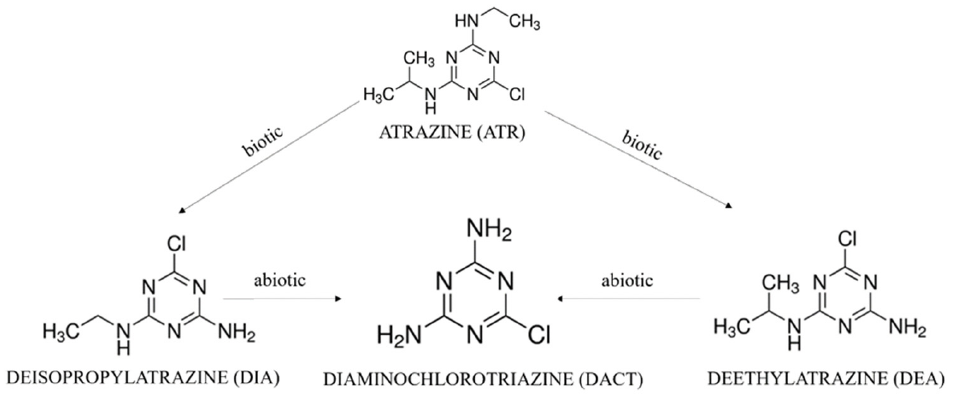
Figure 1. Structure of atrazine and its hydrophilic metabolites, DIA, HA, and DEA. Although practices that minimize atrazine runoff and make it hold onto the field have been promoted [8], atrazine has been detected in the natural environment. Water soluble metabolites, deisopropylatrazine (DIA; 6-chloro- N -ethyl-[1,3,5]triazine-2,4-diamine) and deethylatrazine (DEA; 6-chloro- N -isopropyl-[1,3,5]triazine-2,4-diamine), can be found along with the parent compound dissolved in natural waters and can be transferred through aquatic media.